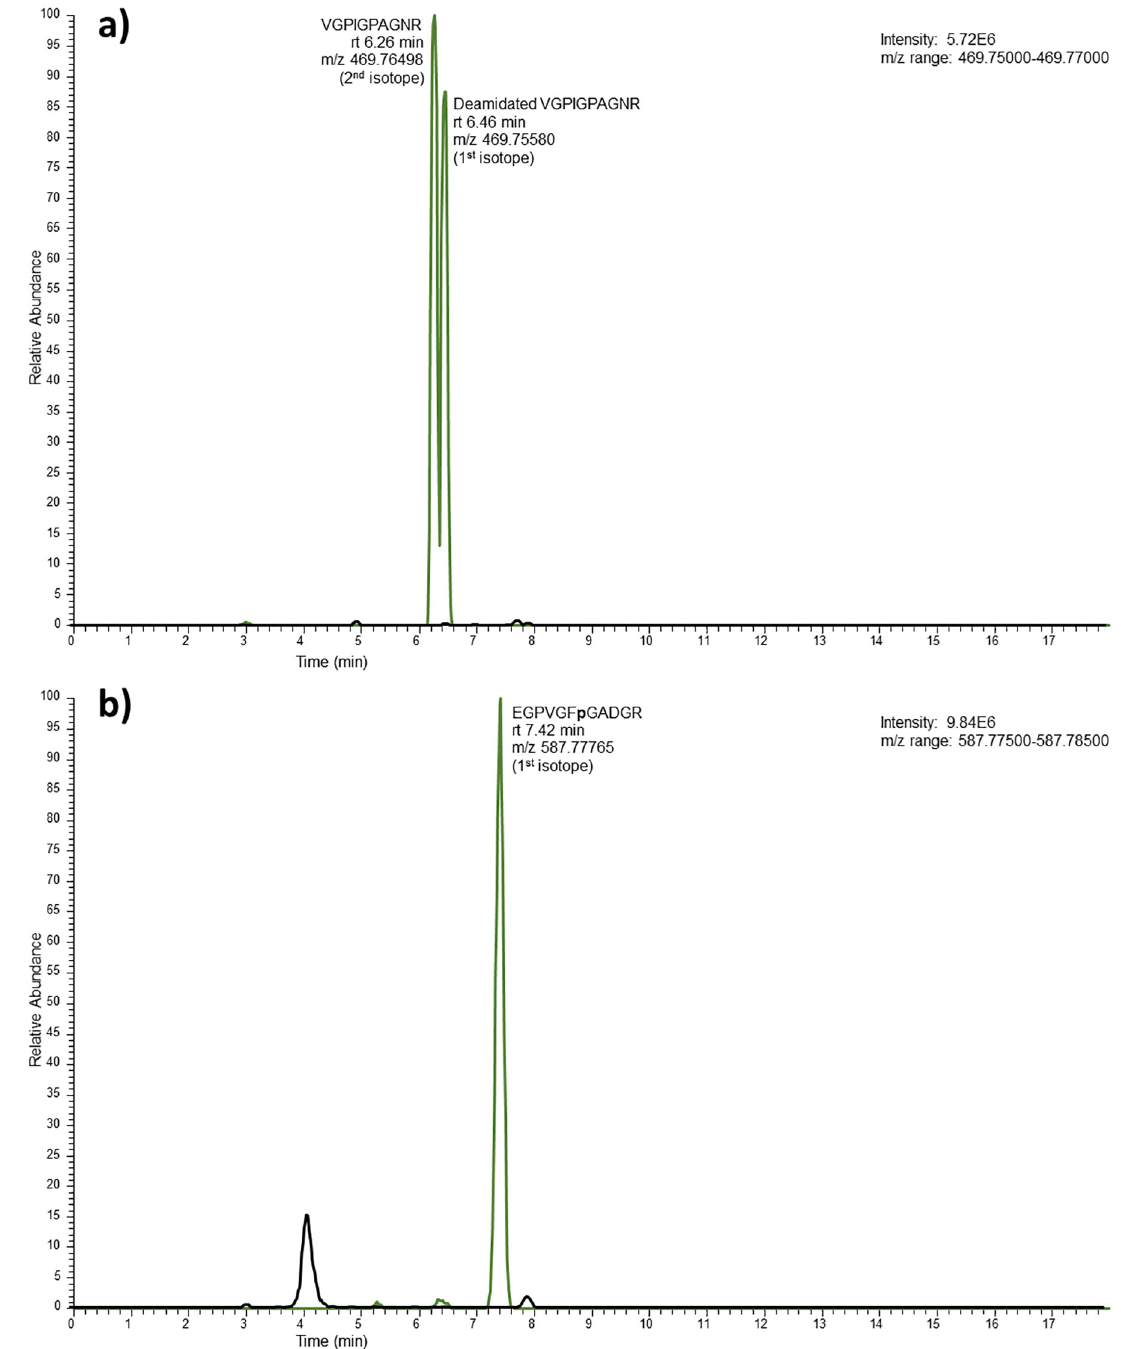
Fig 5. Extracted chromatograms of bird targets. Extracted chromatograms showing the signals for a) VGPIGPAGNR (2 nd isotope) and deamidated VGPIGPAGNR (m/z 469.75 to 469.77) and b) EGPVGF p GADGR (m/z 587.775 to 587.785) in chicken (green lines, brand B) and beef (black lines) broth